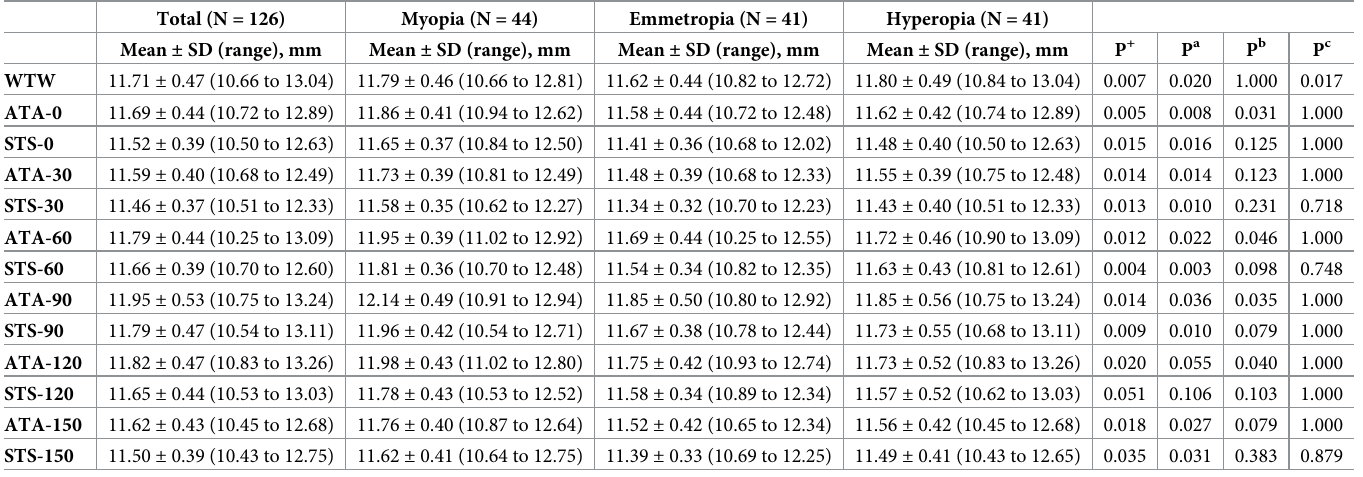
Table 2. WTW, ATA, and STS distances at different